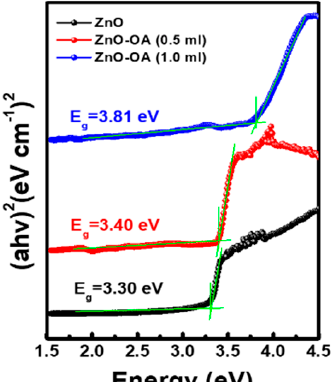
Figure 6. Tauc plot of ZnO QDs and ZnO − OA (0.5 mL, 1.0 mL) QDs.